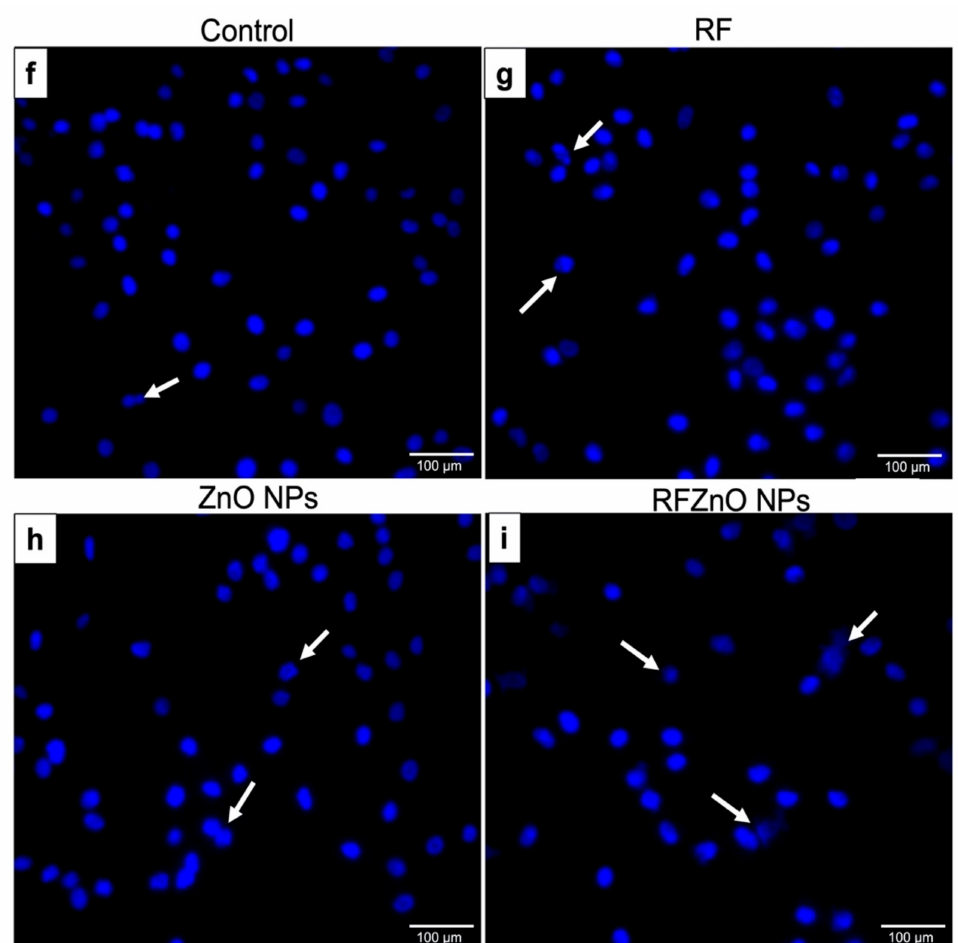
Figure 4. ( a ) Measurement of reactive oxygen species (ROS) in control and treated MCF-7 cells. There was a significant increase in ROS in R. fairholmianus capped zinc oxide nanoparticle (RFZnO NP)-treated groups. Significant differences are shown as * p < 0.05 and ** p < 0.01. Results represent the mean ± SE of three independent experiments. ( b – e ) Qualitative assessment of ROS: ROS are indicated by red fluorescence and nuclei are stained blue. There was increased red fluorescence, and hence increased ROS, in the treatment groups, while in the control group ROS production was lower. in MCF-7 cells; the intensity of nuclear stain was decreased, indicating nuclear disintegration (as shown by the